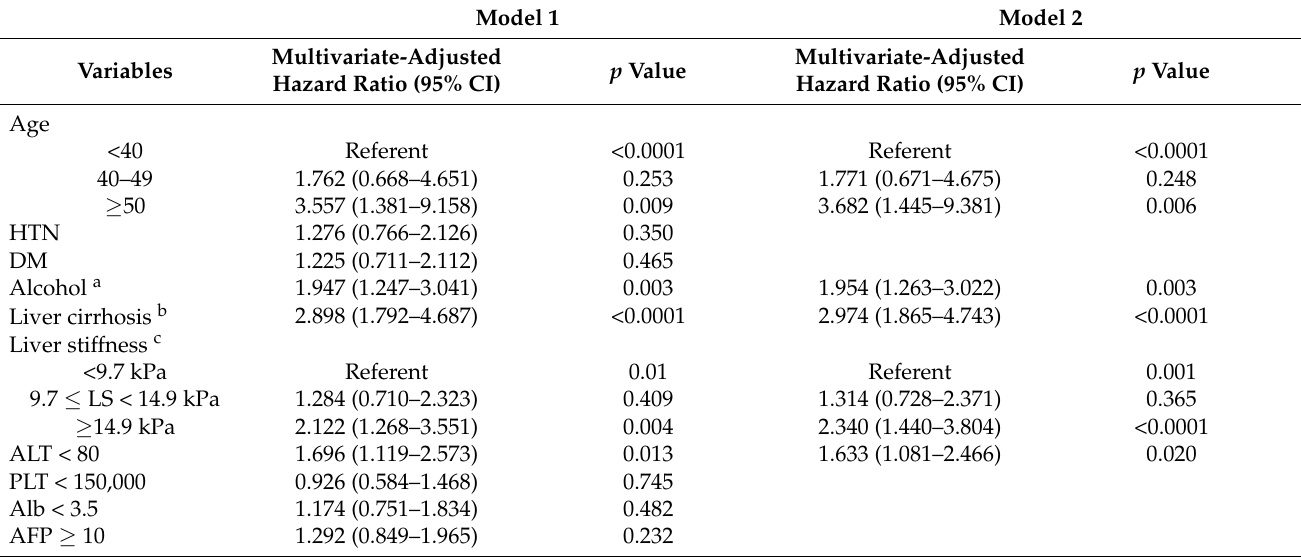
Table 2. Multivariate Cox Regression Analysis for the independent predictors of hepatocellular carcinoma in the derivation cohort ( n =